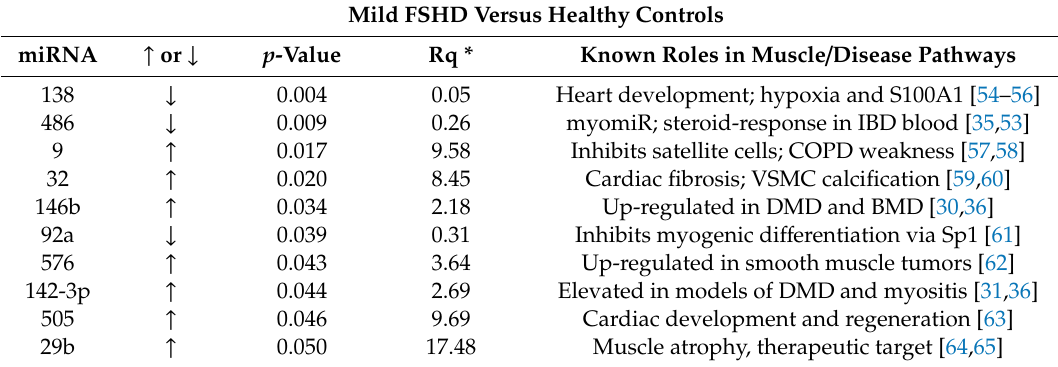
Table 2. Discovery of 19 circulating miRNAs with altered expression in mild or severe